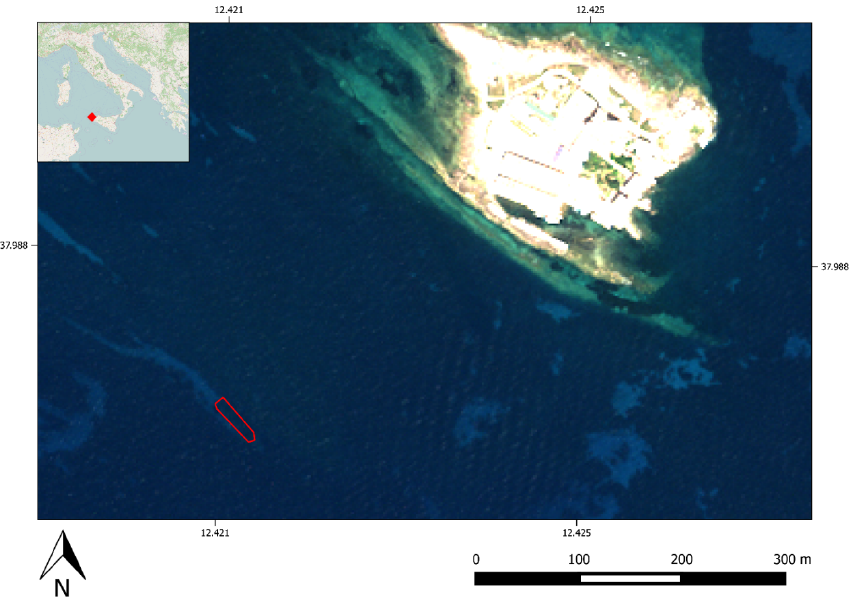
Figure 2: An overview of the Elphis I wreck site using WorldView-2 true-color composite image. The location of the wreck is highlighted in